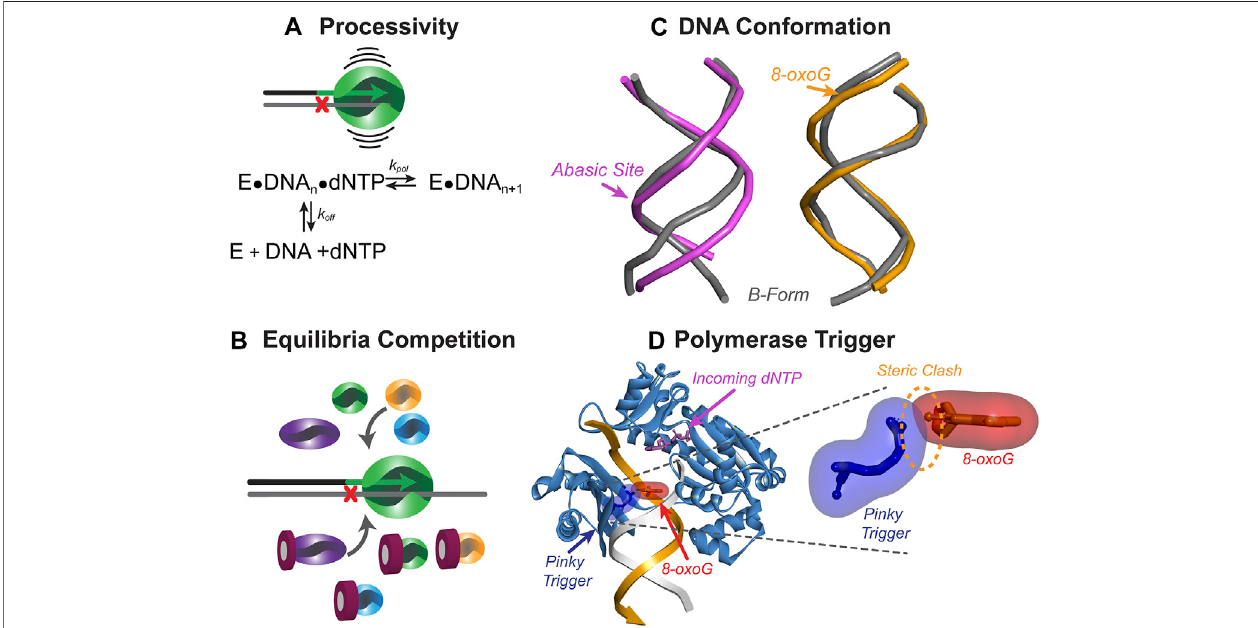
FIGURE 5 | Mechanisms to initiate resumption of high- fi delity synthesis. (A) The processivity of a Pol represents the number of nucleotides inserted before dissociating from DNA and calculated as a ratio of k pol to k off . TLS Pols have lower processivity than HiFi Pols and can readily dissociate from DNA when the bypassed lesion is no longer in the active site. (B) DNA-damaging events can cause upregulation of TLS Pols, leading to concentration-dependent competition between Pols in solution for access to the DNA substrate. (C) DNA lesions can alter the conformation of the DNA, making extension of the nascent strand more dif fi cult for the synthesizing Pol. Abasic site duplex (pink, PDB: 2HSS (Chen et al., 2007)) show more distortion than 8-oxo-G duplex (orange, PDB: 5IZP (Hoppins et al., 2016)) comparedtoB-formDNA(grey).Arrowshowsthepositionofthelesion (D) Template-strandlesionsarebypassedbyTLSPols,howeverasthelesionisexitingtheactive site, a steric clash may occur between a speci fi c amino acid residue (i.e., Pinky Trigger) and the damaged template base to destabilize binding and further extension. Shown is the ternary Sso Dpo4 complex (PDB:ID 1JX4) with oxygen modelled in the 8-position of the guanine in the − 3 position on the primer